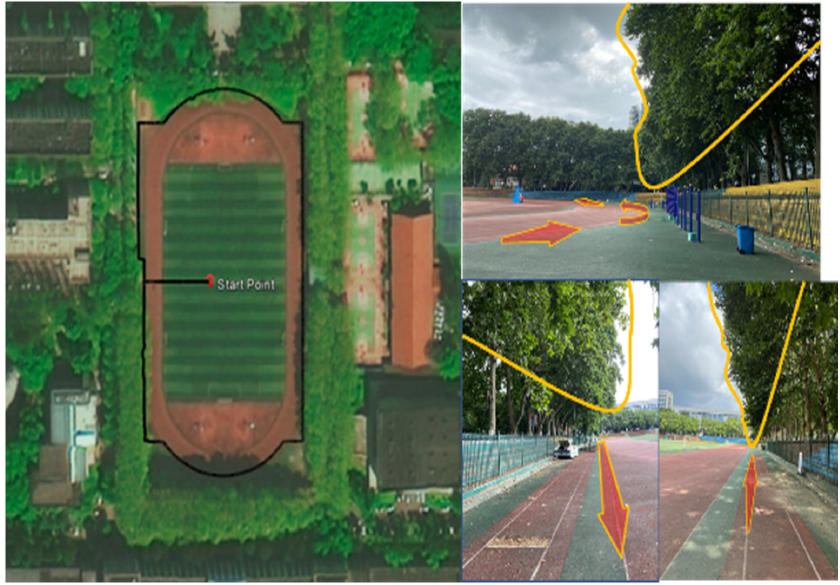
Figure 10. The experiment environment.